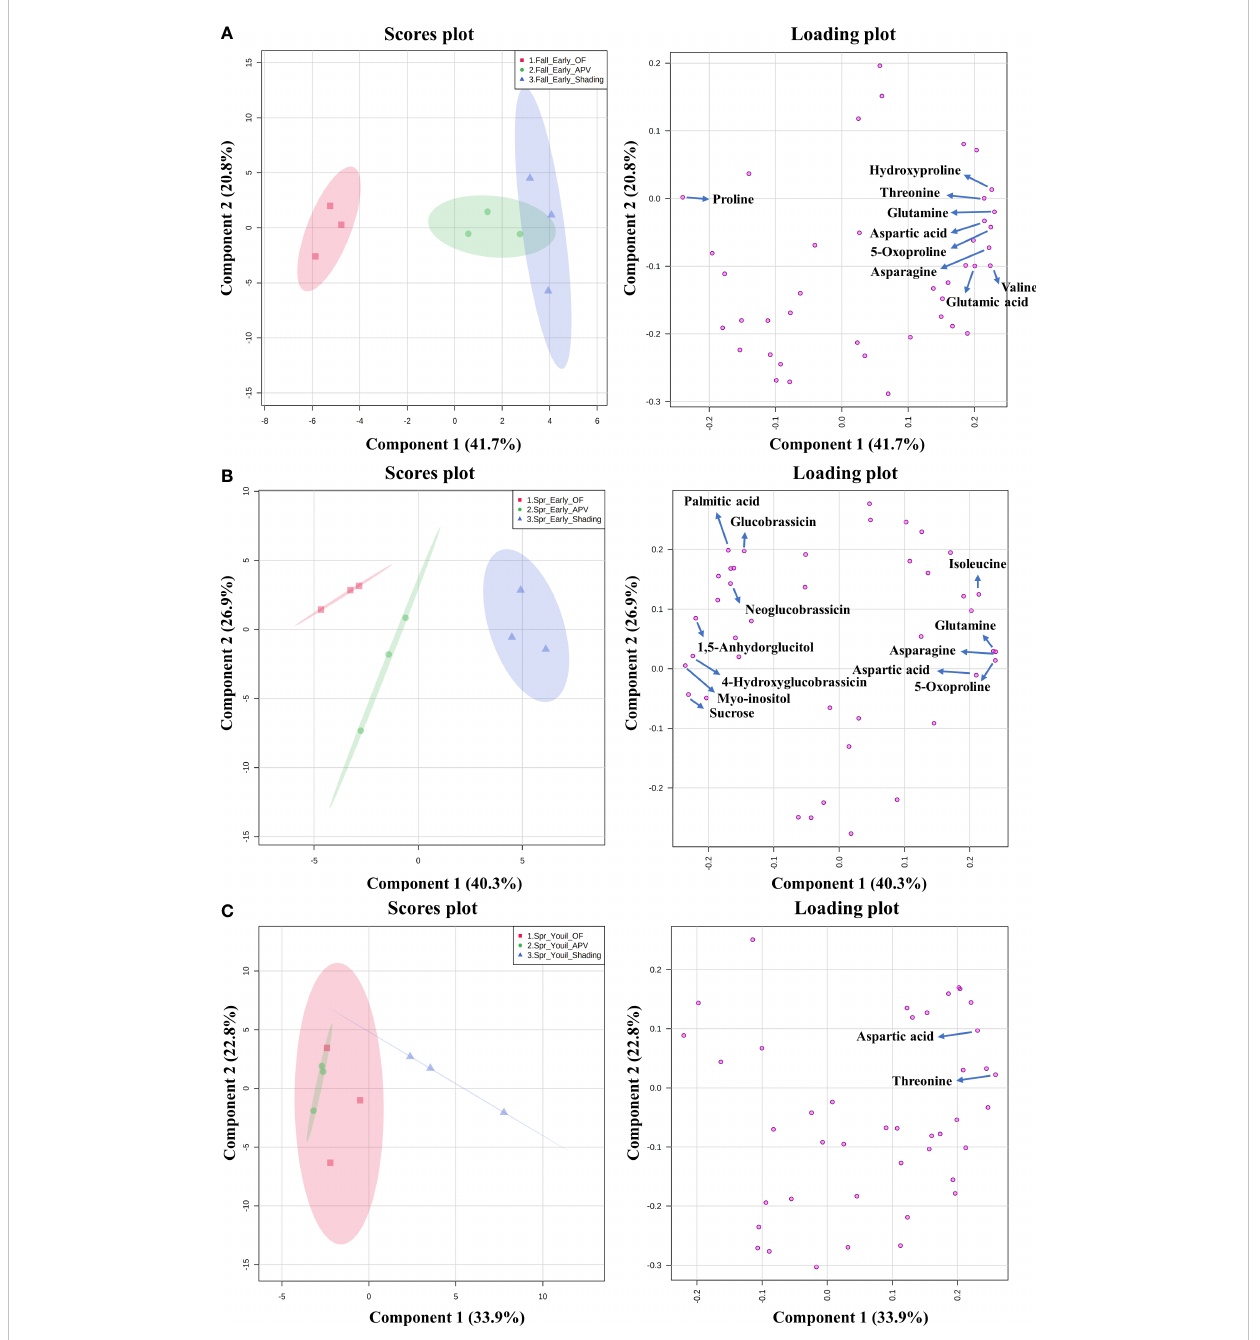
FIGURE 4 The principal component analysis (PCA) o analyzed metabolites from fall ‘ Earlyyou ’ (A) , spring ‘ Earlyyou ’ (B) and spring ‘ Youil2ho ’ (C) by treatment type. The squares, circles, and triangle on each graph indicate the replicate of OF, APV, and additional shading treatment in APV groups, respectively. The results are presented in score plots (left column) and loading plots (right column) to visually help distinguish among the groups and mark certain metabolites among the groups by HSD Tukey ’ s test marked as their compound name of the leading plot